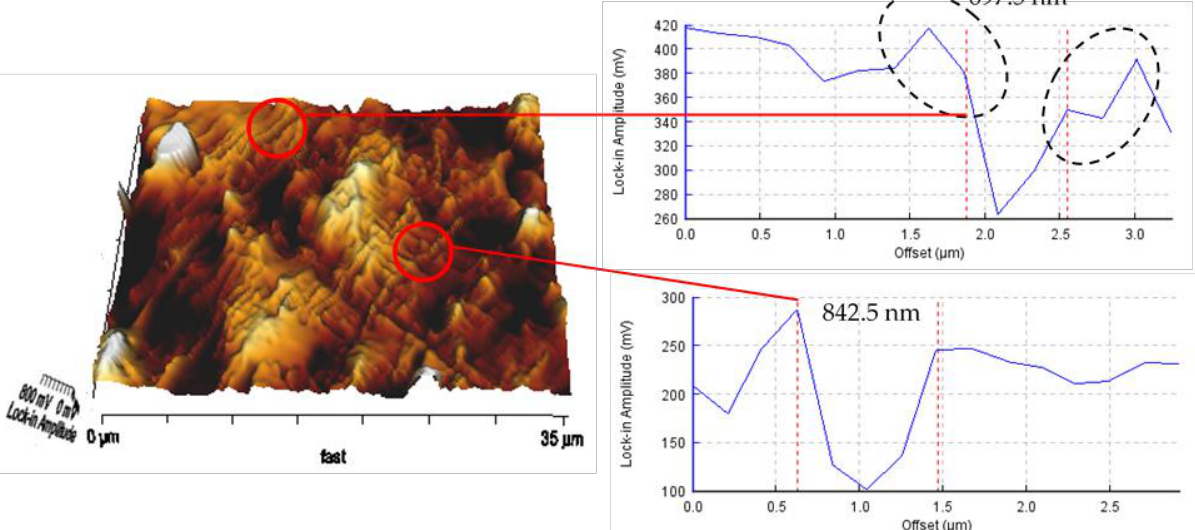
Figure 6. AFM three-dimensional amplitude micrograph of shear band deformation in the MRE matrix. The dashed ovals represent the shear band deformation zone.